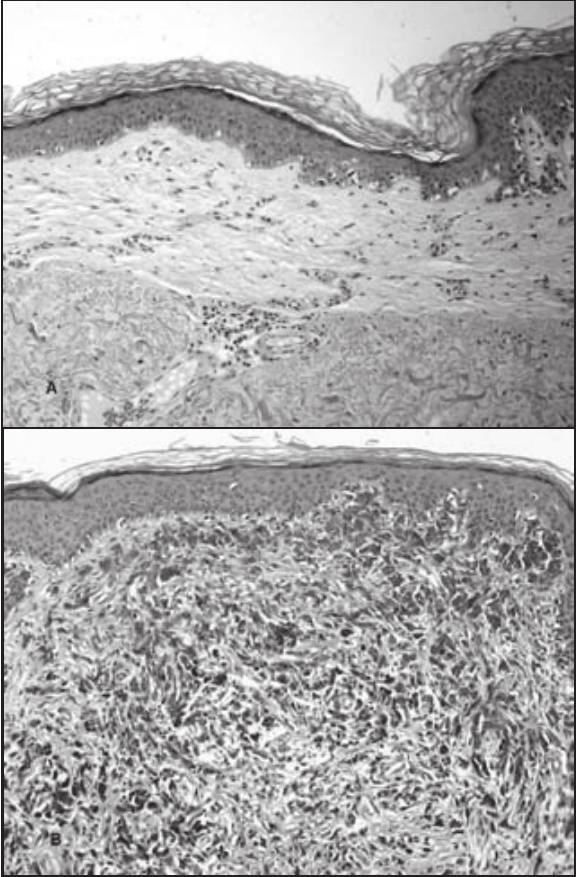
Figura 3 – Regressão tardia caracterizada por: A – Rarefação de células neoplásicas na epiderme e ausência na derme, marcada fibrose em disposição horizontal, vasos neoformados e esparso infiltrado inflamatório. Caso 41, HE, 100x (aumento original). B – Fibrose, proliferação vascular e acentuada diminuição das células neoplásicas na epiderme associadas à presença de acúmulo nodular de melanófagos na derme (melanose). Caso 25, HE, 100x (aumento original) HE: hematoxilina e